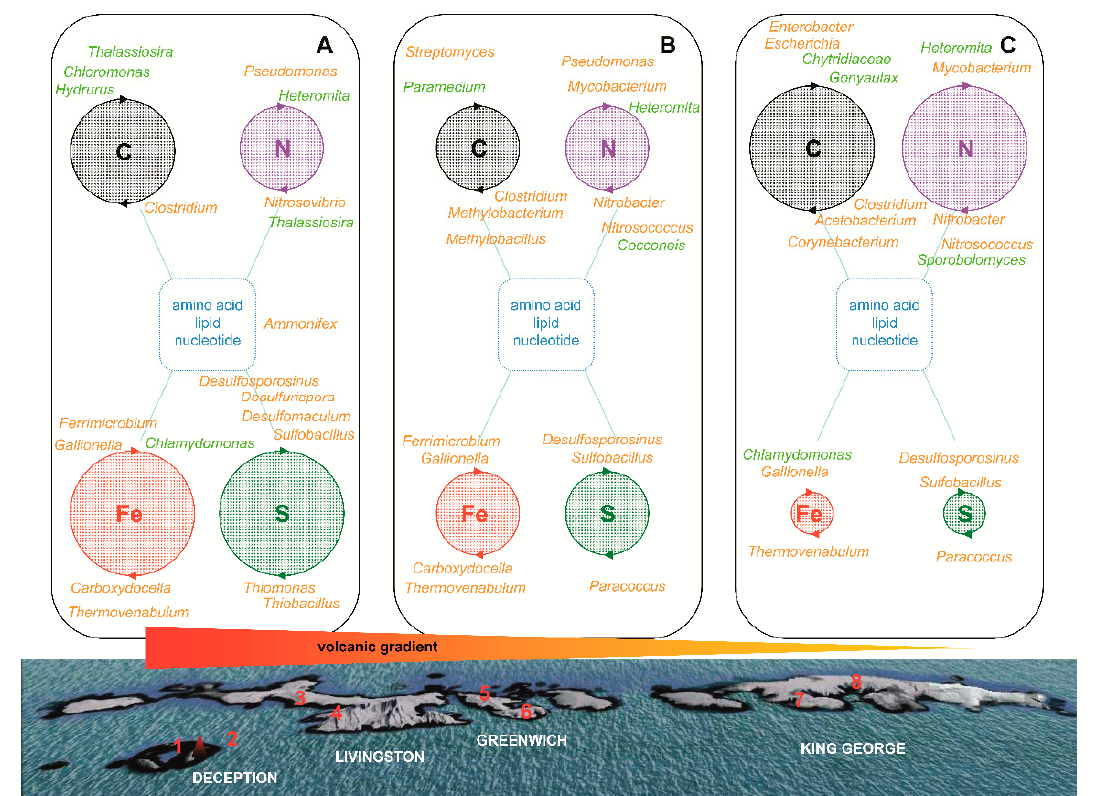
Figure 7. Insights into biogeochemical cycles based on the volcanic gradient along South Shetland glaciers. Some key members of carbon, nitrogen, iron, and sulfur cycles in glaciers were represented at the genus level (bacteria colored in orange and microeukaryotes colored in green). The size of the circles was calculated by the number of operational taxonomic units (OTUs) occurring at a frequency of more than 3% at sample points: ( A ) sample points 1 and 2, ( B ) sample points 3 to 6 and ( C ) sample points 7 and 8.